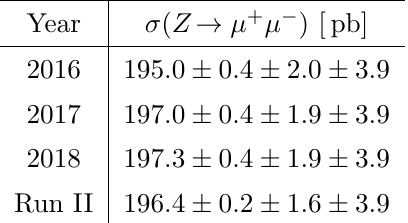
Table 13 . Measured total Z -boson cross-section for different datasets. The first uncertainty is statistical, the second systematic, and the third is due to the luminosity.